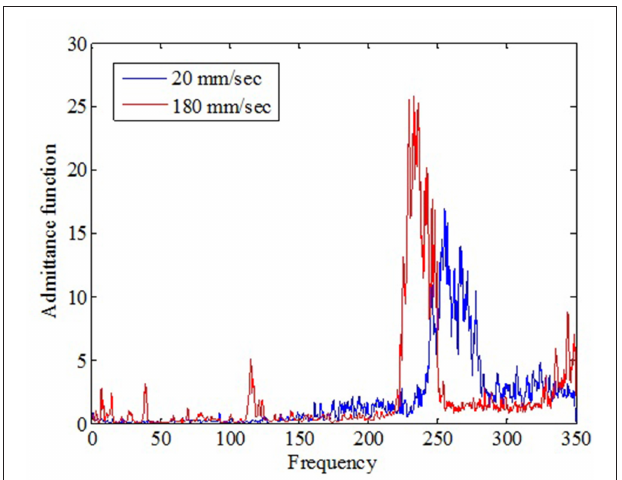
FIGURE 13 | Admittance functions for two different translating speeds.